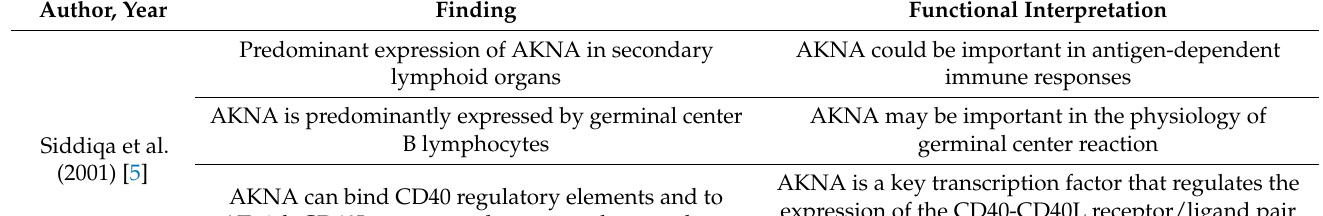
Table 7. Main findings on the functional role of the AKNA in the reported in